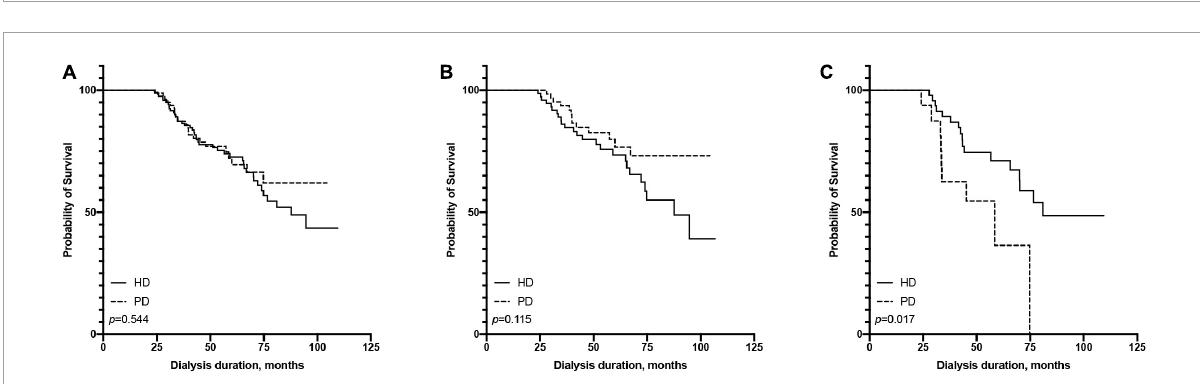
FIGURE5 Comparison of pass 2 years survival rate between hemodialysis and peritoneal dialysis by age subgroups [ (A) all patients, (B) ≤ 65 years old group, (C) > 65 years old group].